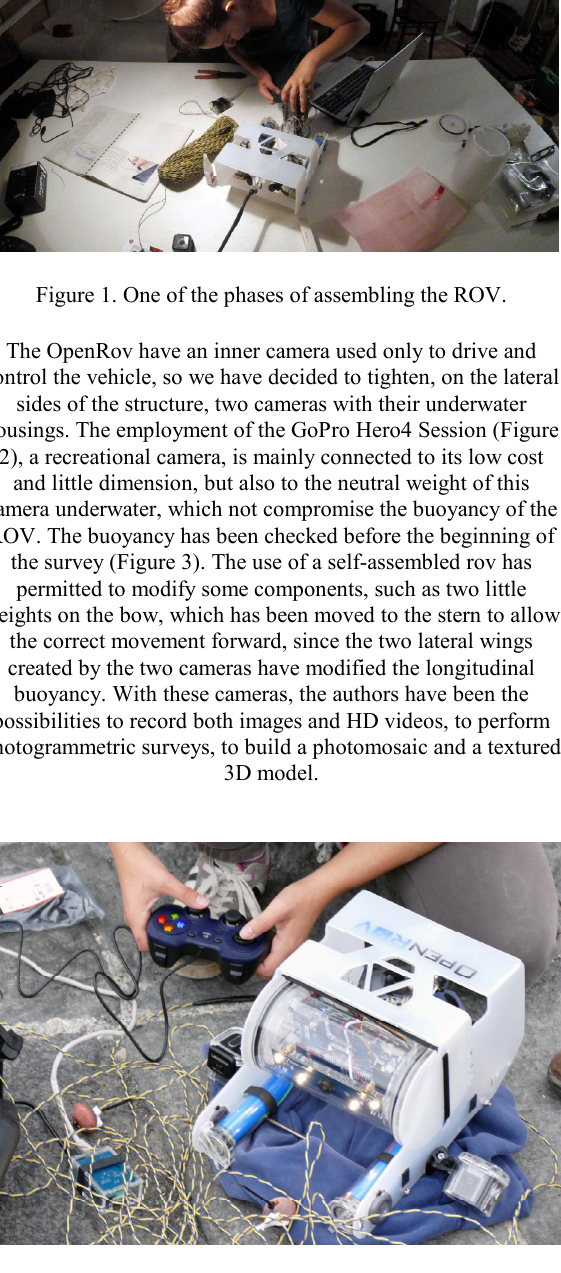
Figure 2. The OpenRov with the two GoPro mounted on sides.